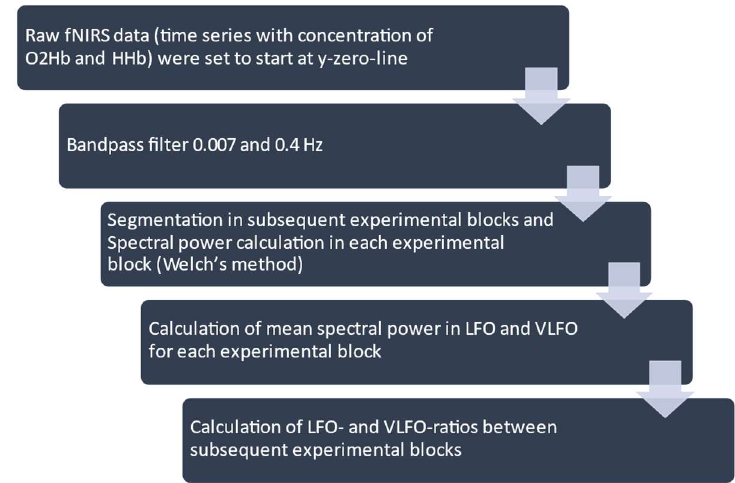
Figure 3. Processing of functional near-infrared spectroscopy (fNIRS) data. O2Hb = oxygenated hemoglobin. HHb = deoxygenated hemoglobin. LFO = low-frequency oscillations. VLFO = very-low-frequency oscillations.